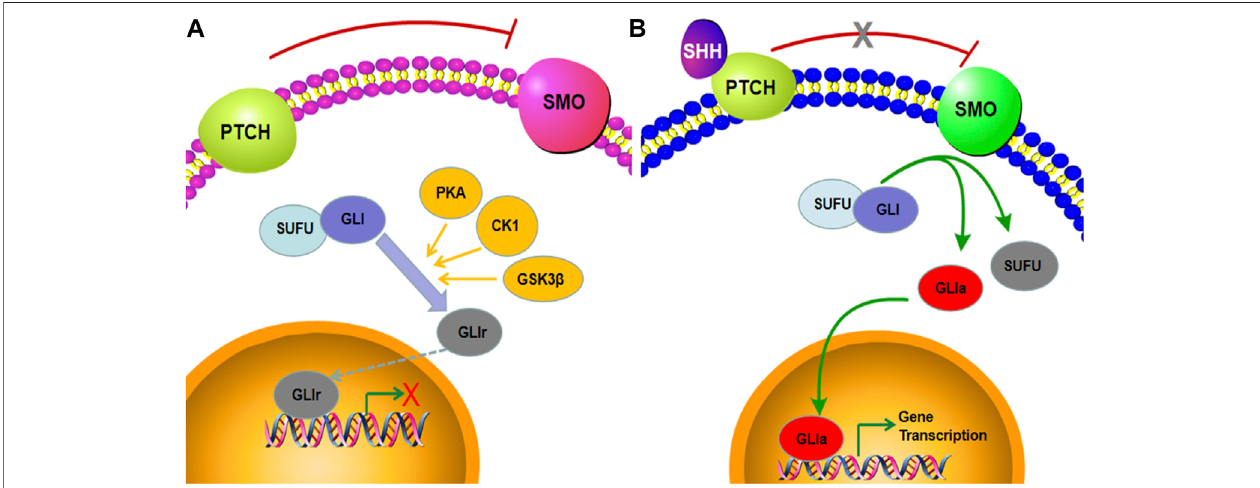
FIGURE 1 | Graphical representation of active and inactive SHH signaling pathways. (A) When SHH is absent, the full-length GLI is phosphorylated by PKA, CK1, andGSK3 β andproteolyticcleavagedintotheGLIrepressor,whichsubsequentlysuppressestheexpressionofSHHtargetgenes. (B) InthepresenceoftheSHHligand, SMOinhibitsthesequestrationbySUFUandphosphorylationbyPKA,CK1,andGSK3 β ,leadingtotheformationoftheGLIactivatorandultimatelytoinductionoftarget gene transcription.